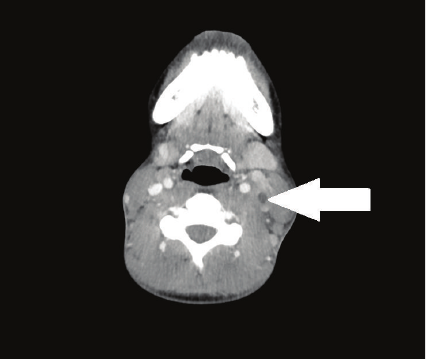
Figure 2: Contrast CT scan of the neck showing a thrombus in the left jugular vein (arrow).